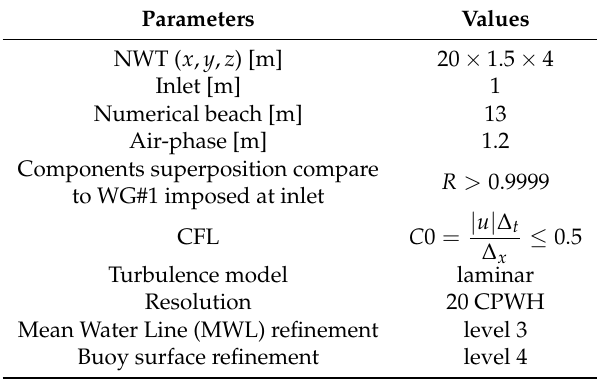
Table 4. Parameters of three-dimensional-Numerical Wave Tank (3D-NWT) for extreme Wave Structure Interaction (WSI).